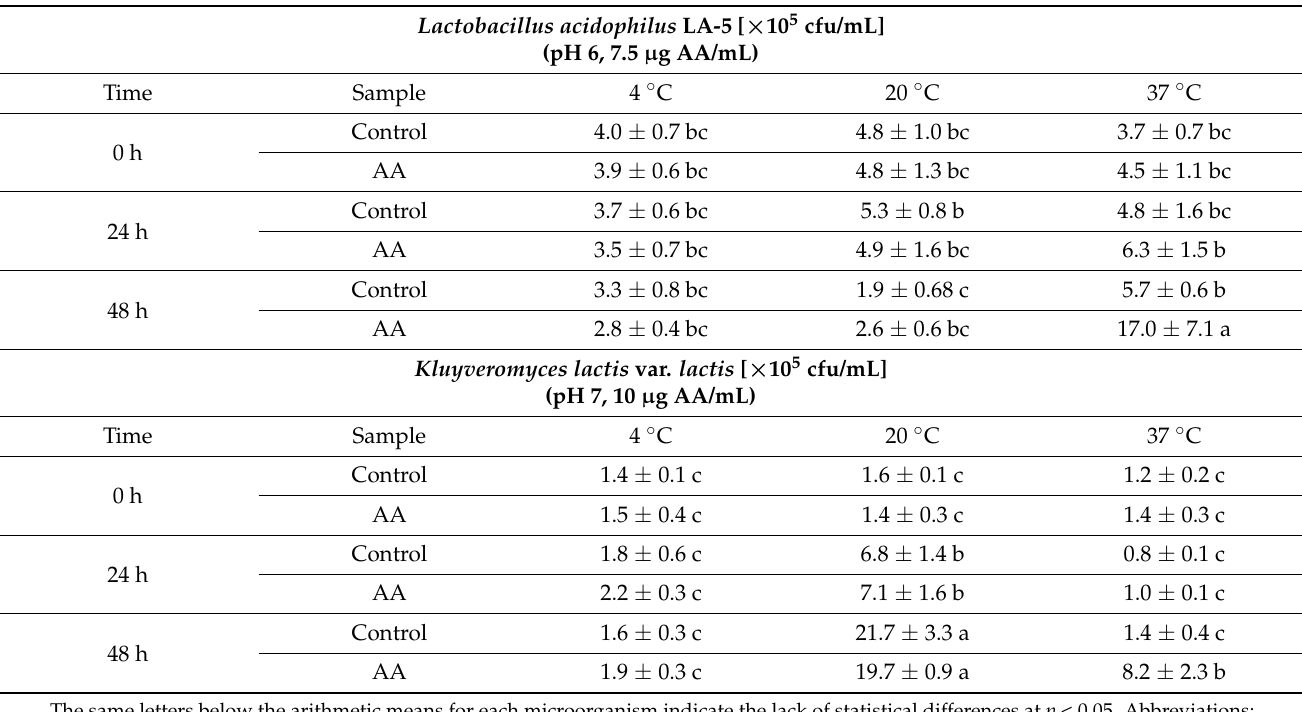
Table 3. The impact of temperature on the growth of Kluyveromyces lactis var. lactis , and Lactobacillus acidophilus LA-5 in the presence of acrylamide (AA) (n =